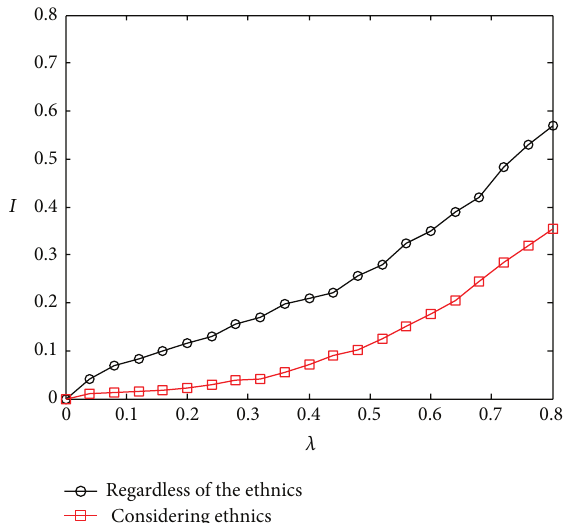
Figure 1: Computer simulations of SIRS model on BA scale-free networks ( 𝑁 = 2000 , ⟨𝑘⟩ = 4 ). In the BA scale-free networks, we do not adopt any immunization strategies, 𝜁 𝐴𝐵 = 𝜁 𝐵𝐶 = 𝜁 𝐴𝐶 = 0.7 .